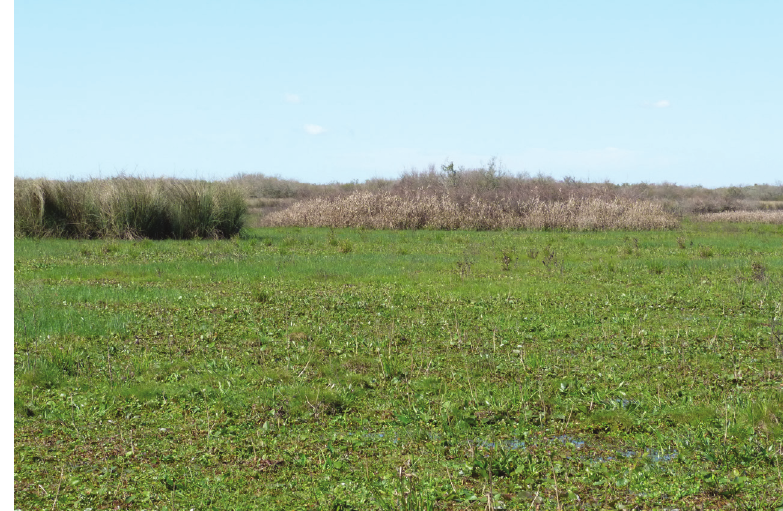
Figure 7. Type locality of Austrolebias queguay sp. n., wetlands of middle Queguay river